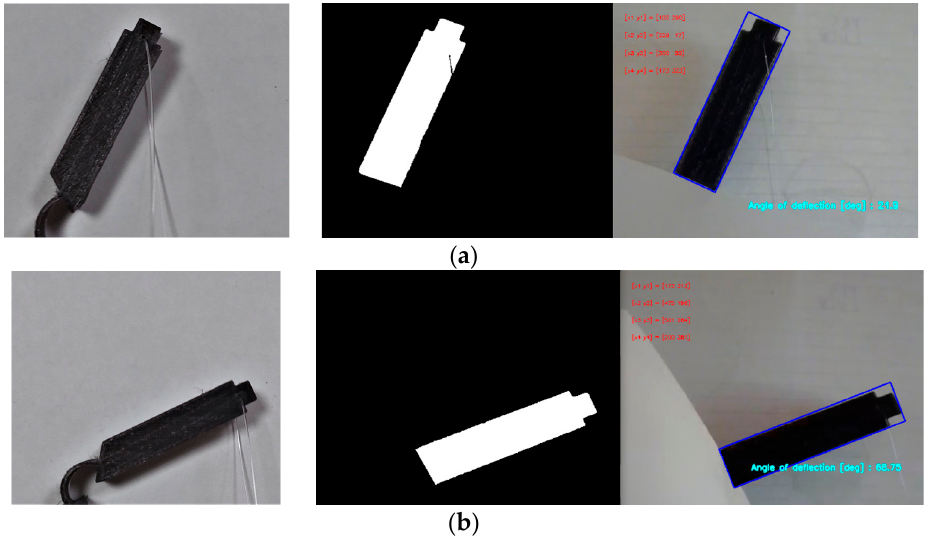
Figure 9. Example of different joint positions: ( a ) unloaded and ( b ) loaded. Original images (left column) of the 3D-printed finger. Segmented object regions represented with white pixels in the segmented binary images (middle column). Detected object bounded with an extracted minimal rectangle represented by blue-colored rectangle (right column).